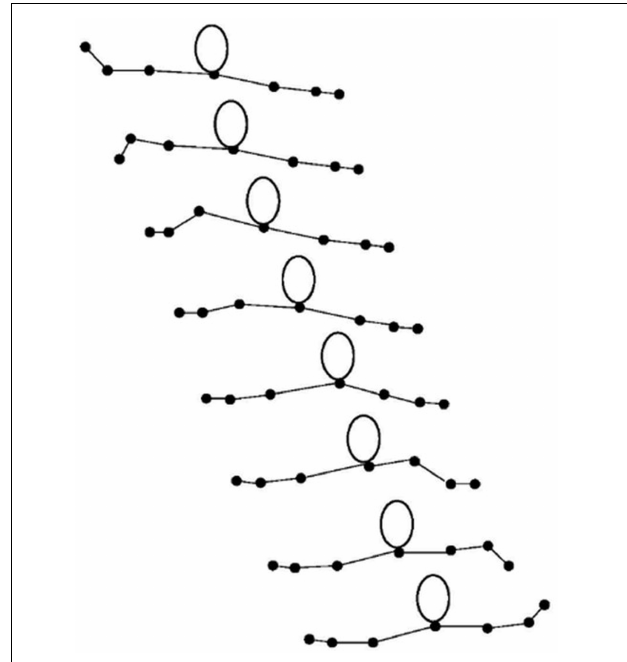
FIGURE 1 | The left-to-right hip-hop wave represented by eight line drawings taken (from to bottom) equidistantly in time from a video rendering. In addition, an IRED was attached to a headset atop of the head as a reference of